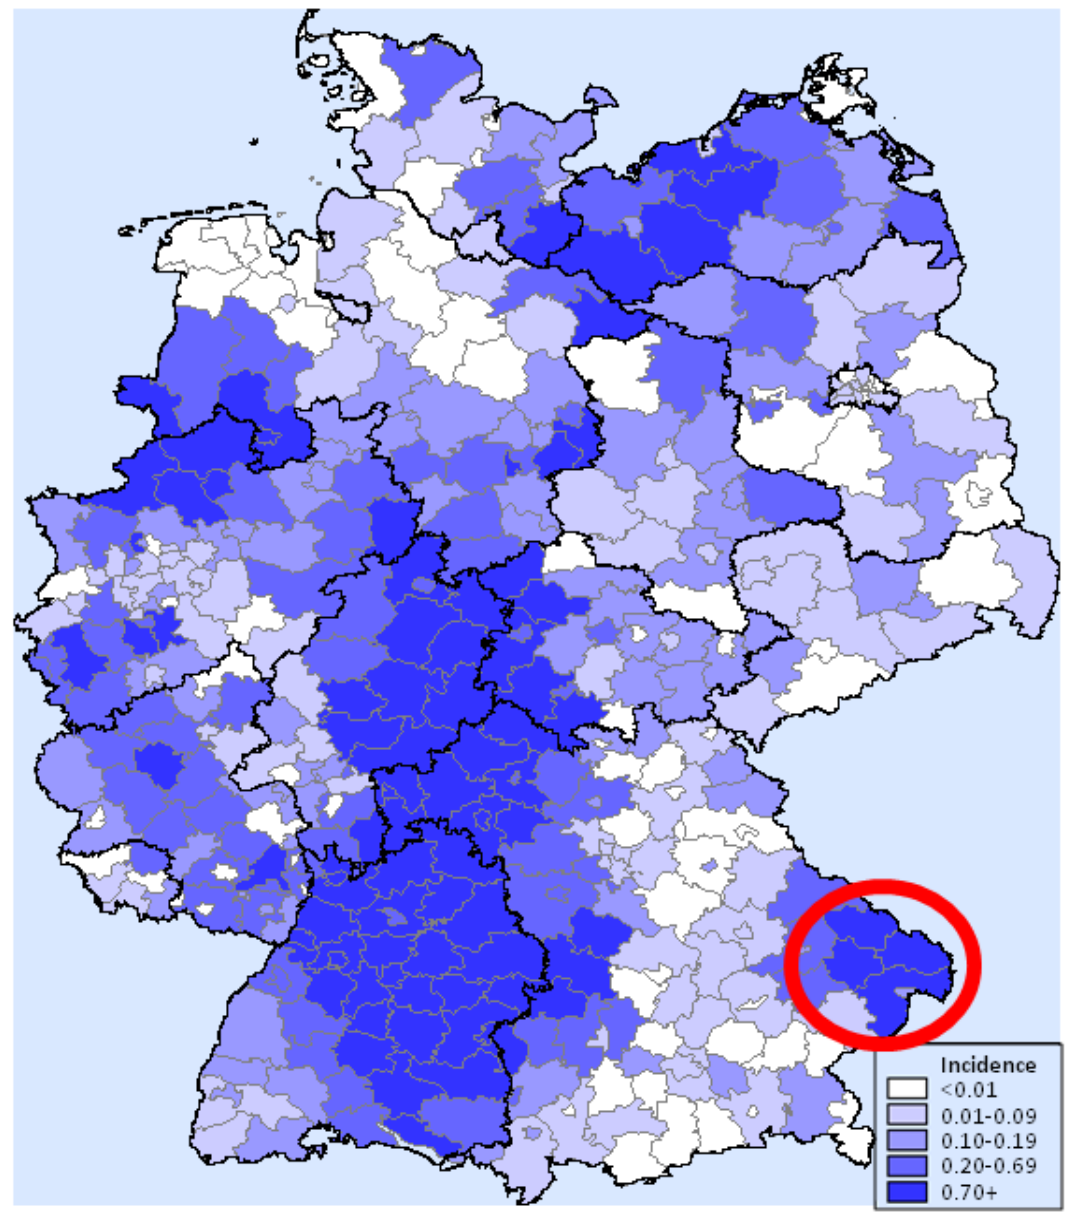
Figure 1. Cumulative incidence (2001–2013) of clinically apparent hantavirus infections per 100,000 inhabitants population in administrative districts of Germany [11]. The study region of Lower Bavaria is marked in